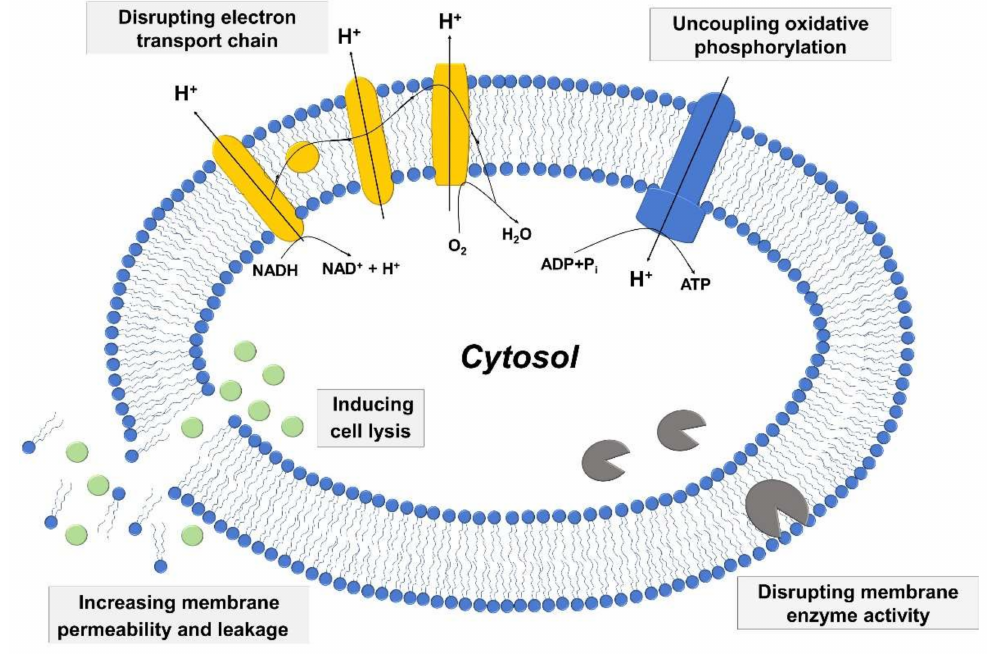
Figure 2. Schematic representation of mechanisms behind the antibacterial activity of fatty acids and